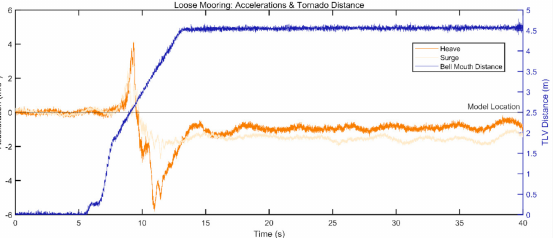
Figure 10. Heave and Surge accelerations and bell mouth distance (Tornado location) for configura- tion